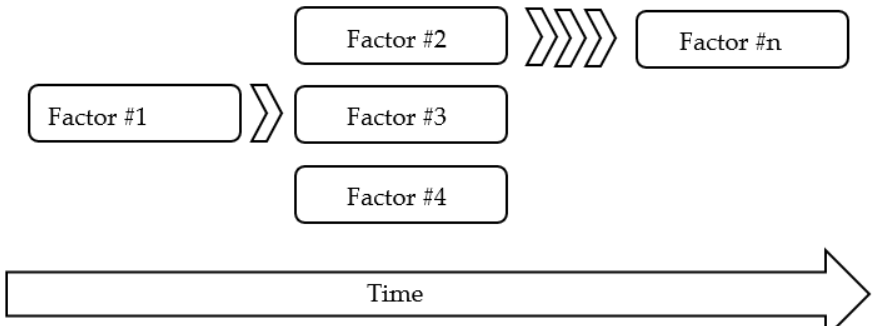
Figure 1. Multiplication of variables.